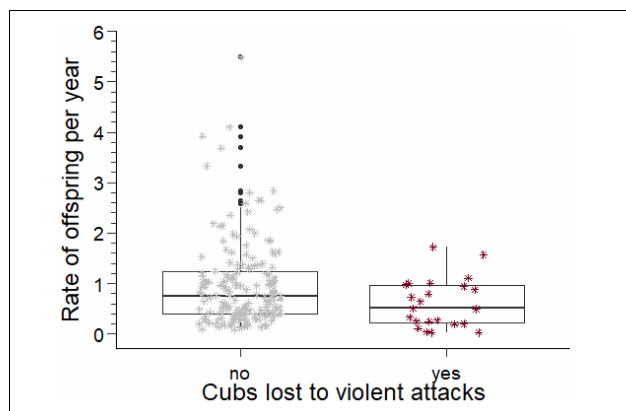
FIGURE 2 | Rates of offspring produced per year by males who did and did not lose cubs to violent attack, adjusted for losses of cubs to the estimated rate of violent attack. The box comprises the interquartile range, the horizontal line is the median, the whiskers cover the range of values 1.5 times the value of the interquartile range, the asterisks indicate data points in the range between 1.5 and 3 times the value of the interquartile range, and open circles values beyond 3 times the value of the interquartile range.